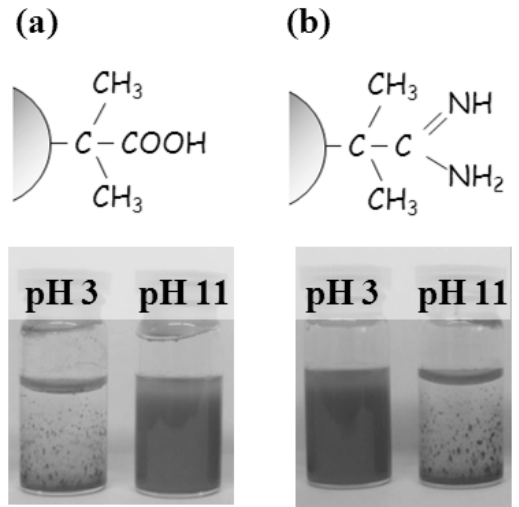
Fig. 6 Surface structure and the stability of surface modified SiC nanoparticle in pH controlled water after modified by (a) AIBN and (b)